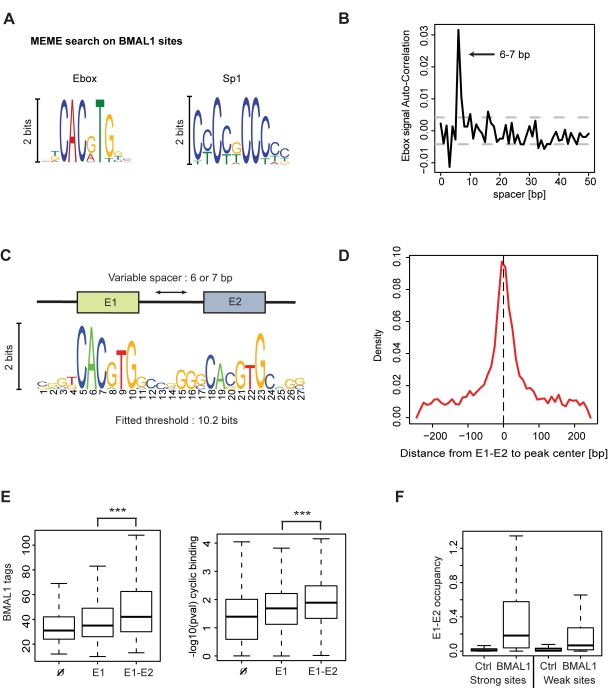
Genomic sequence preference of BMAL1 binding sites.(A) Overrepresented motifs found using MEME [56]. DNA sequences in the window of ±50 bp around each BMAL1 site were used for the sequence analysis. The enrichment of Sp1 sites reflects the proximity of BMAL1 sites to TSSs (Figure 2B). (B) Autocorrelation analysis shows that E-box motifs come in tandem, with a spacing of six or seven nucleotides. Grey dashed lines represent the 95% confidence interval. (C) HMM for the tandem E-box motif (E1-E2 element) converges to one canonical E-box site with threshold at 7.2 bits and a tandem E1-E2 element with threshold at 10.2 bits (Table S5). To train the model, each sequence was given a weight proportional to the number of BMAL1 tags at peak binding. (D) Distribution of distances from E1-E2 positions to peak centers. The E1-E2 elements are sharply located around the inferred binding location. (E) Sites with E1-E2 elements have significantly more tags (left) and show more robust rhythmic binding of BMAL1 (right) than sites without E-boxes (Ø) or with single E-boxes (E1). ***, p<5×10−5, Student's t test. (F) BMAL1 sites are strongly enriched in E1-E2 instances compared to control regions. Control regions were taken 500 bp downstream of each site.